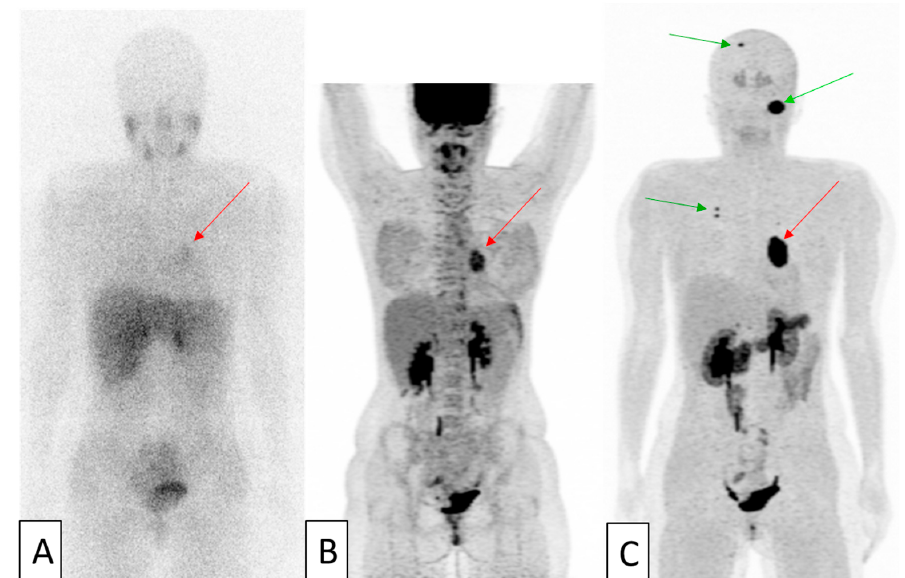
Figure 2. An example of 37-year-old patient with pluri-metastatic paraganglioma. MIP (maximum intensity projections) images of the realized 123MIBG-scintigraphy ( A ), FDG-PET ( B ) and FDOPA-PET ( C ) are shown. The subject has a mediastinal lesion, barely seen on 123MIBG-scintigraphy and clearly positive with the others tracers (red arrows). Pulmonary and skull lesions (green arrows) were only visible on FDOPA-PET. Images courtesy of Dr C. Ansquer © Catherine Ansquer